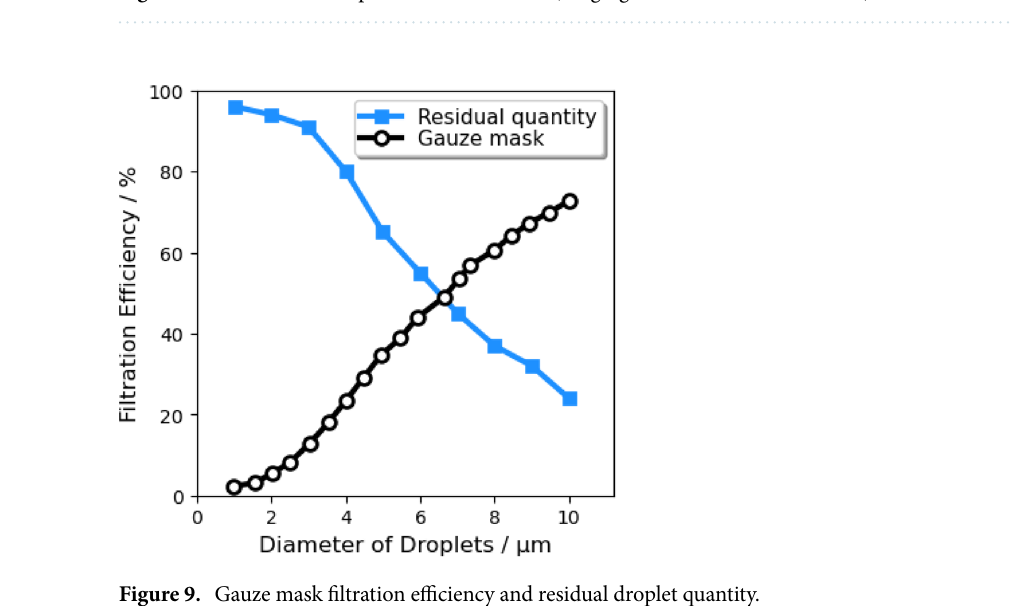
Figure 9. Gauze mask filtration efficiency and residual droplet quantity.